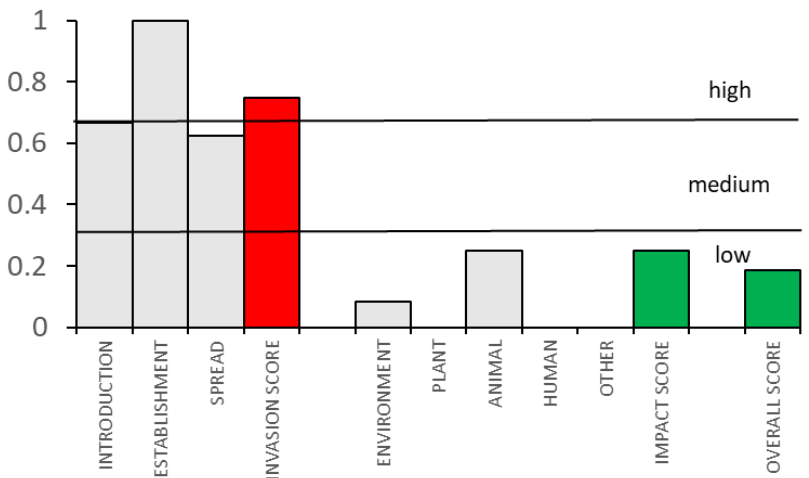
Figure 4. Harmonia + results applied to D. villosus in the River Adda. Continuous lines indicate the thresholds between high/medium/low level of invasiveness proposed by [51]: high risk, species with scores > 0.66; medium risk, between 0.33 and 0.66; low risk, <0.330. The colour red indicates high level of invasiveness while the colour green indicates a low level of invasiveness.